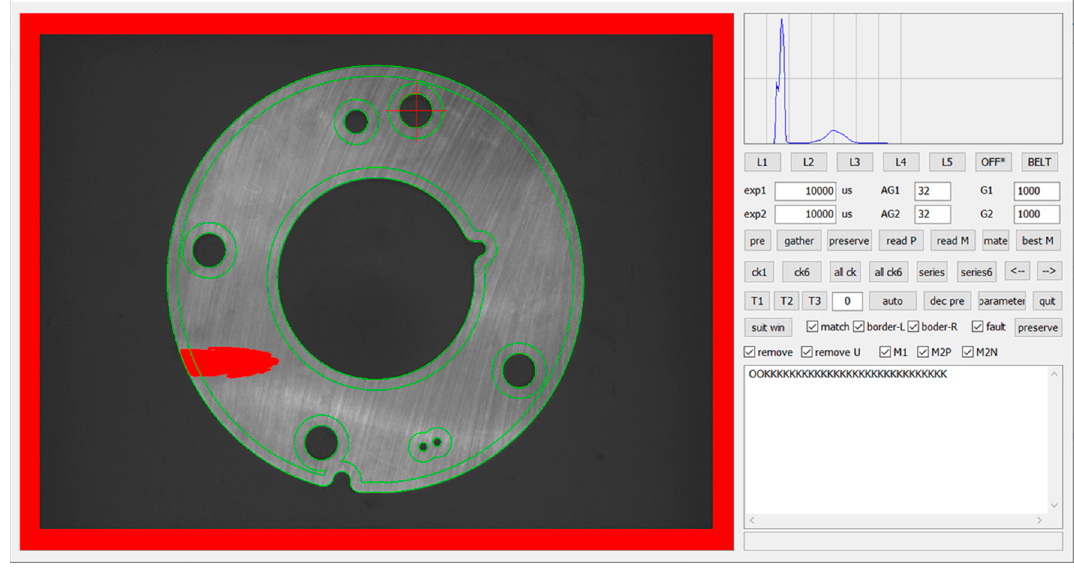
Figure 15. Software system interface.